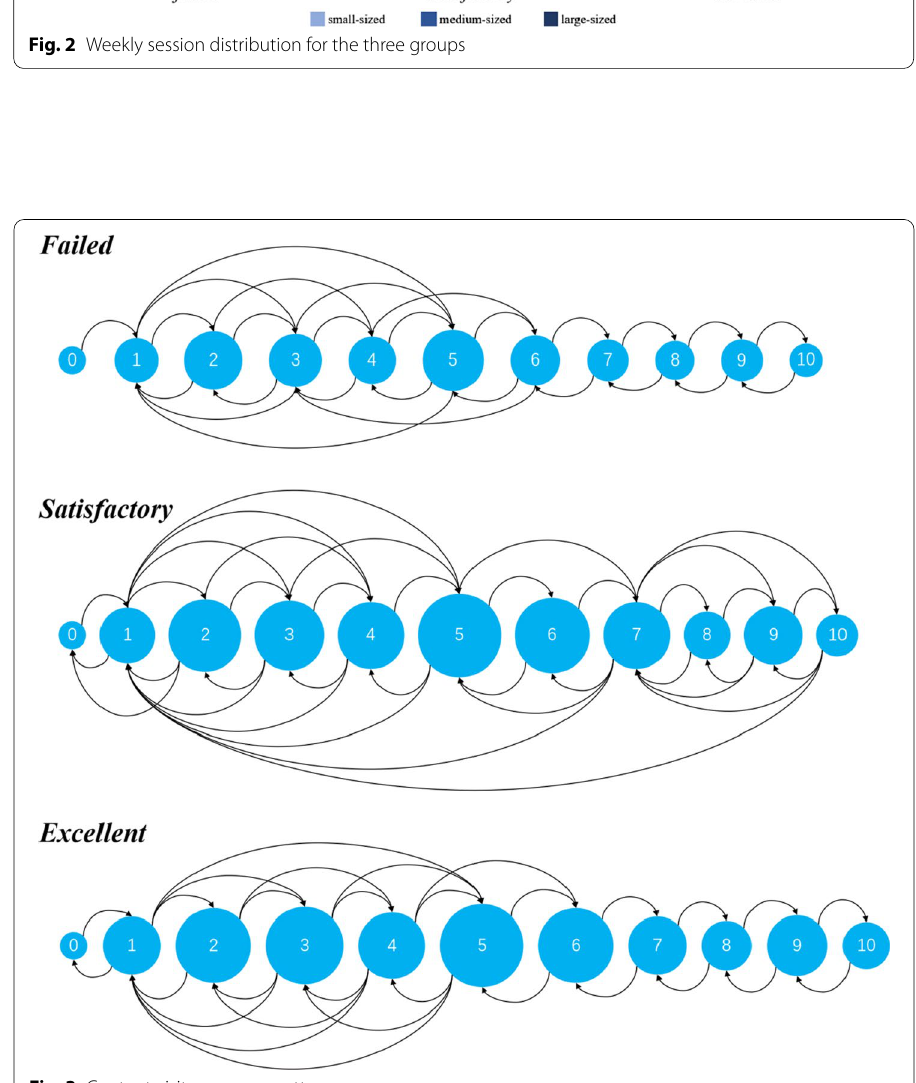
Fig. 3 Content visit sequence